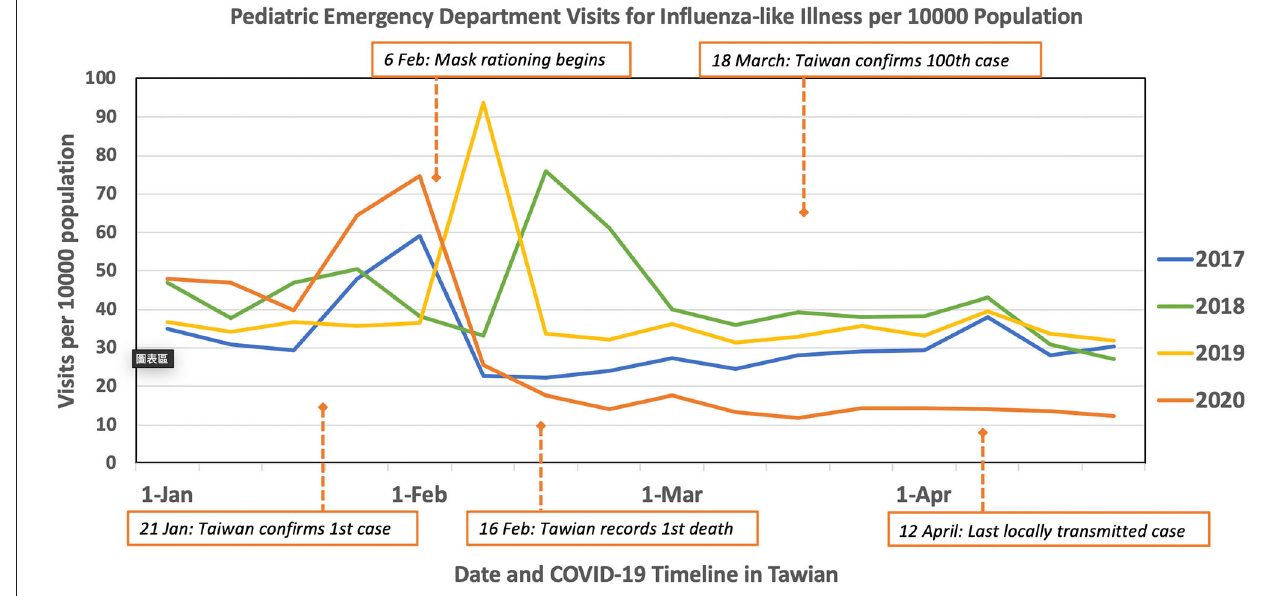
FIGURE 1 | Comparison of respiration tract related pediatric ED visit per 10,000 population between 2017, 2018, 2019, and 2020 in Taiwan.